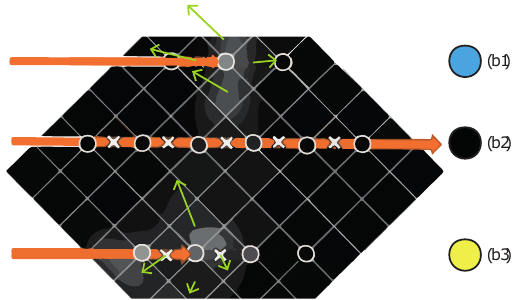
Figure 8. Representation of how the voxels are sampled by the raycast algorithm using the implicit surface model: samples the first voxel value at a given threshold is sampled.